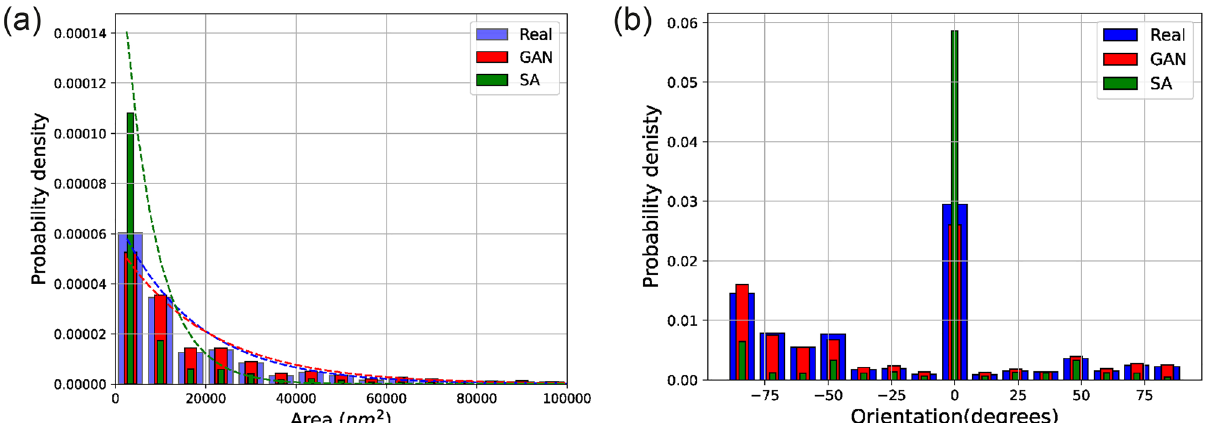
Figure 8. Comparison of real and reconstructed images in terms of pore properties in the meta-igneous rock. ( a ) Probability density of the pore area was calculated from 128 randomly sampled images. Dashed lines show the estimated probability density functions fitting the data. ( b ) Distribution of pore orientations between − 90 (clockwise) and +